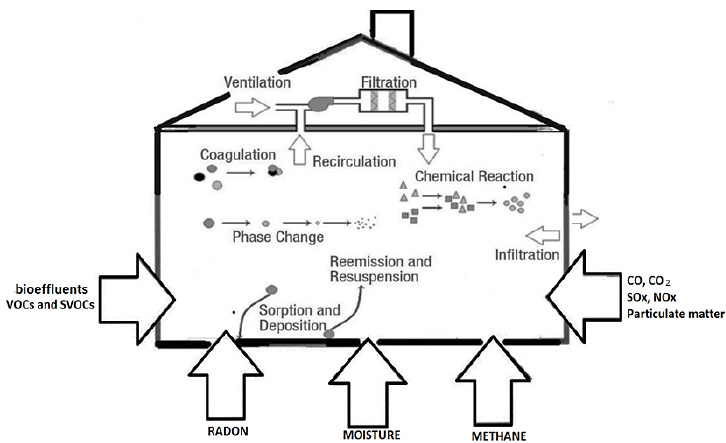
Figure 1. Overview of the physical and chemical processes of potential pollution sources in the indoor environment of a building. (VOCs—Volatile Organic Compounds, SVOCs—semi Volatile Organic Compounds).